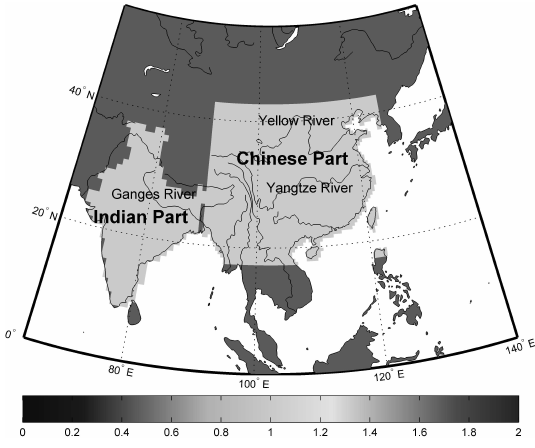
Fig. 1. The study area and major